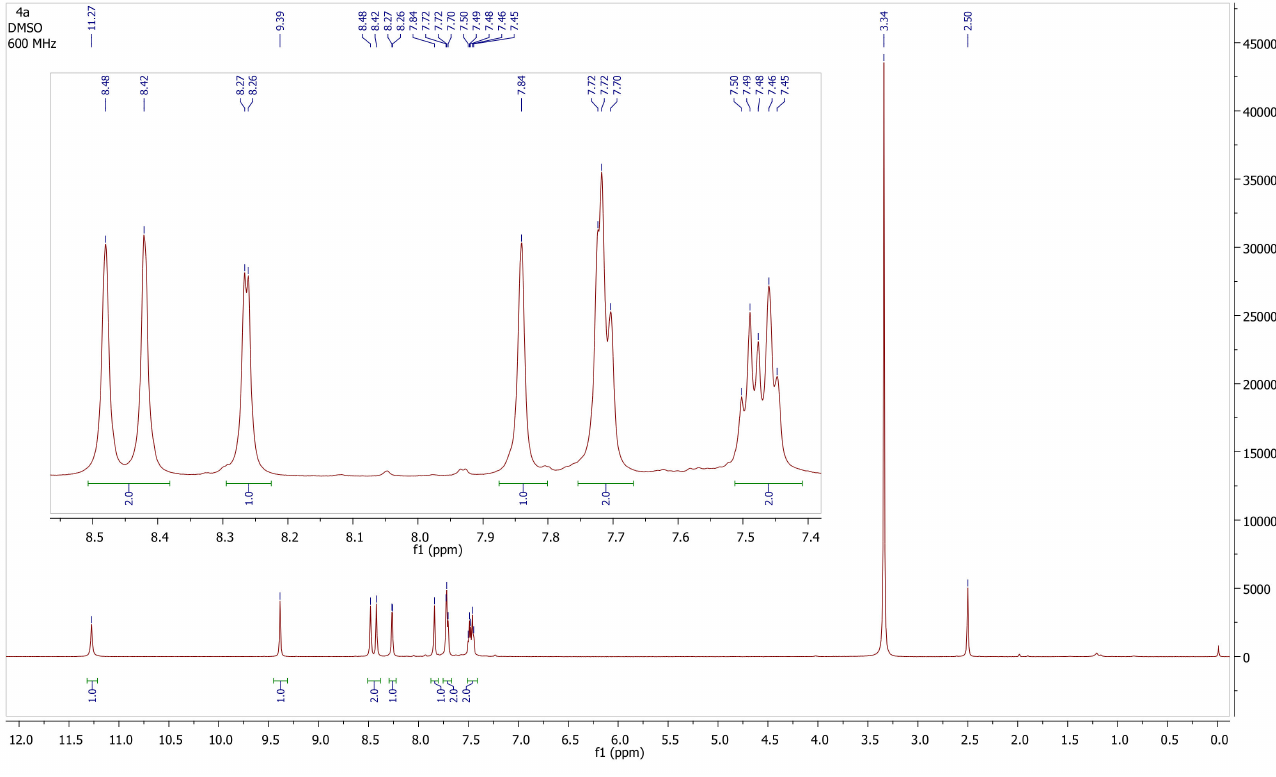
Figure 4. 1 H NMR spectra of compound 4a at 600 MHz.